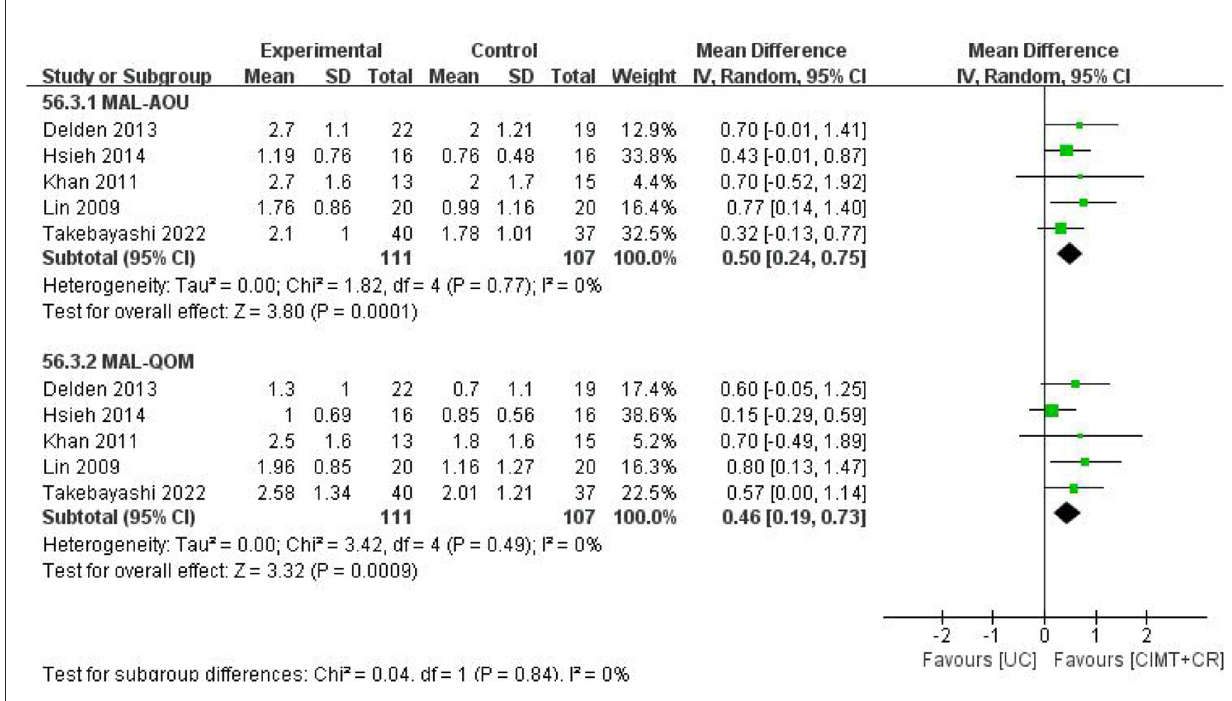
FIGURE7 The forest plot of MAL comparing CIMT plus CR and